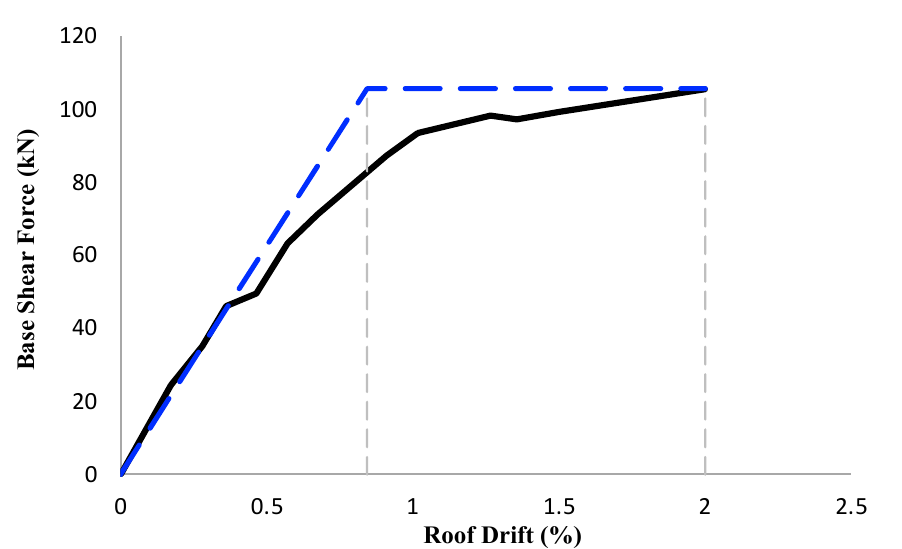
Figure 12. Force-displacement capacity curve for a prototype of tested frame.